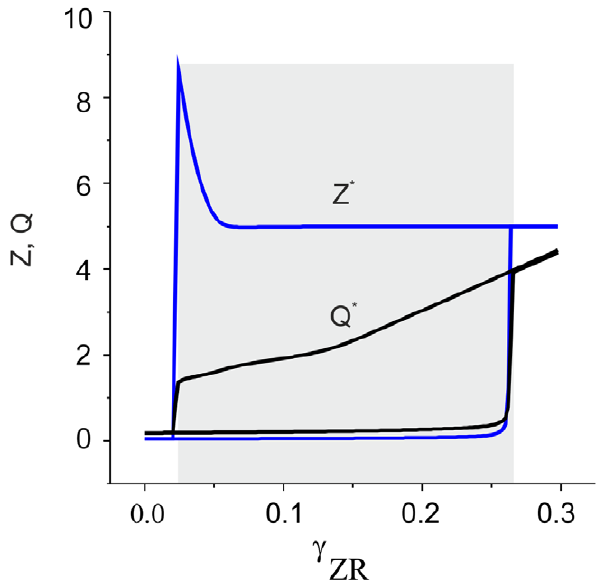
Figure 10. Bistability induced by the ECM receptors regulation cascade. Black and blue curves show stable steady state activity levels and ECM concentrations, depending on the feedback gain. The gray area illustrates bistability. Parameter values: z 0 =p 0 =0, z 1 =p 1 =1, h z =1,k z =0.15, h p =1.5,k p =0.05, a z =0.001 msec 2 1 , b z =0.01 msec 2 1 , a p =0.001 msec 2 1 , a 3 =0.0001 msec 2 1 , a 4 =0.001 msec 2 1 , I 0 =4.5 m A/ cm 2 ,b 0 =6, Q 0 =0.18, and k b =0.4762 .